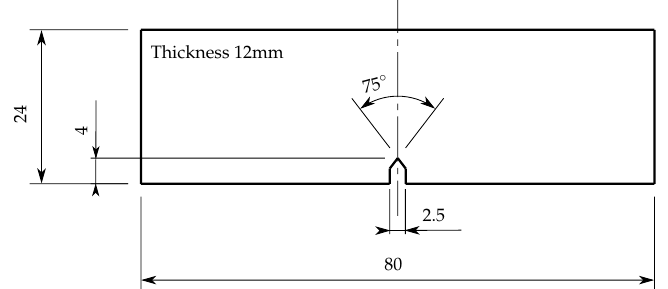
Figure 18. Single edge notched bending specimens (SENB) specimen geometry.